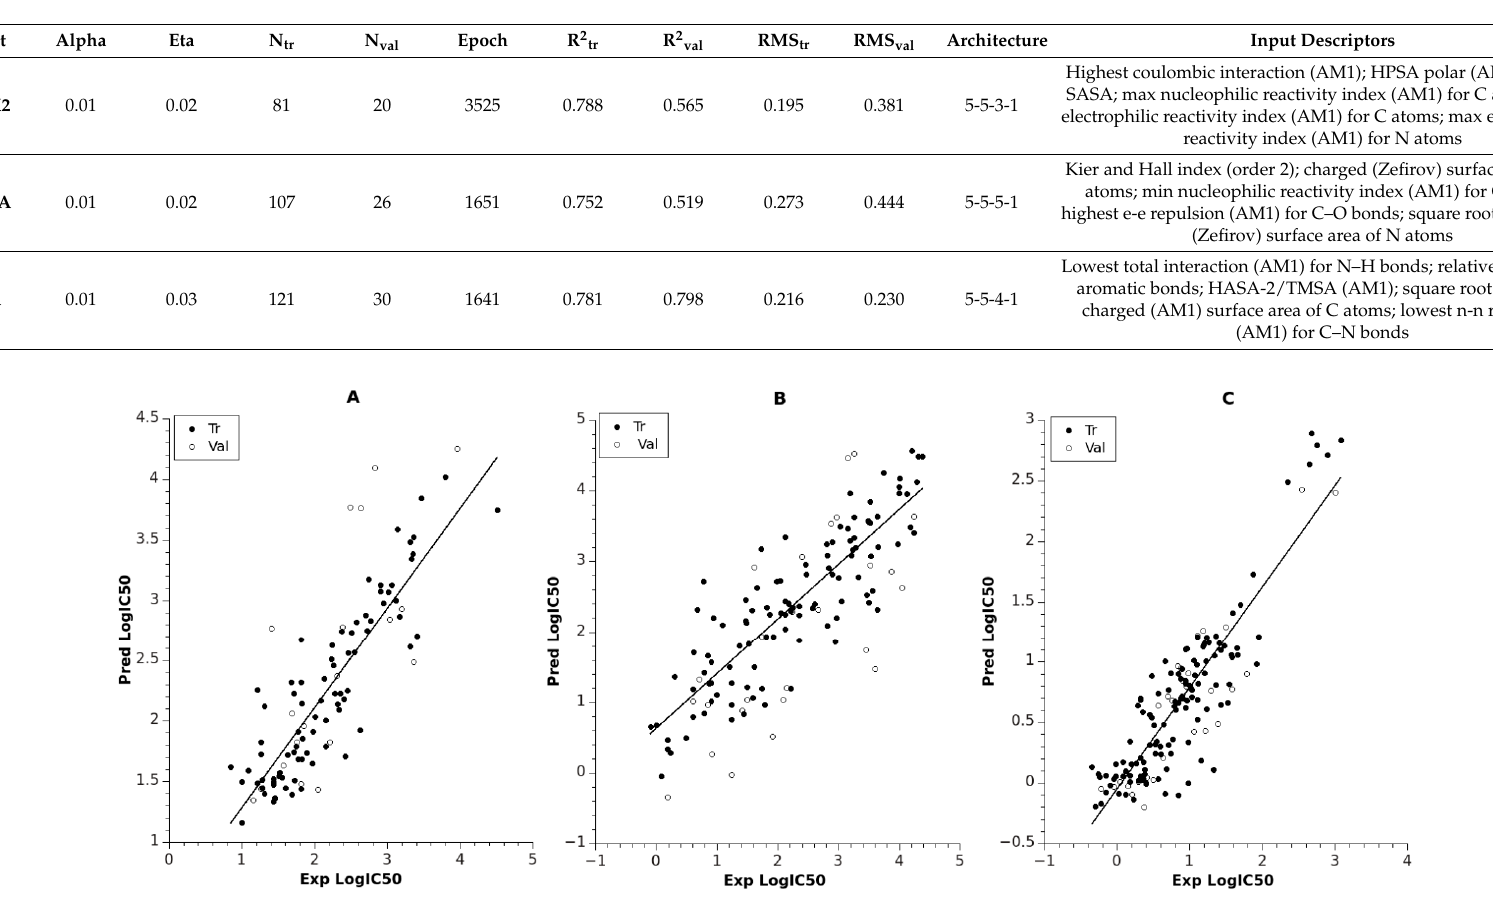
Table 1. Statistical and topological parameters of the artificial neural network (ANN) models. LRRK2, leucine-rich repeat kinase 2; NMDA, N -methyl- D -aspartate; TrkA, tropomyosin receptor kinase A; RMS, root mean squared error.